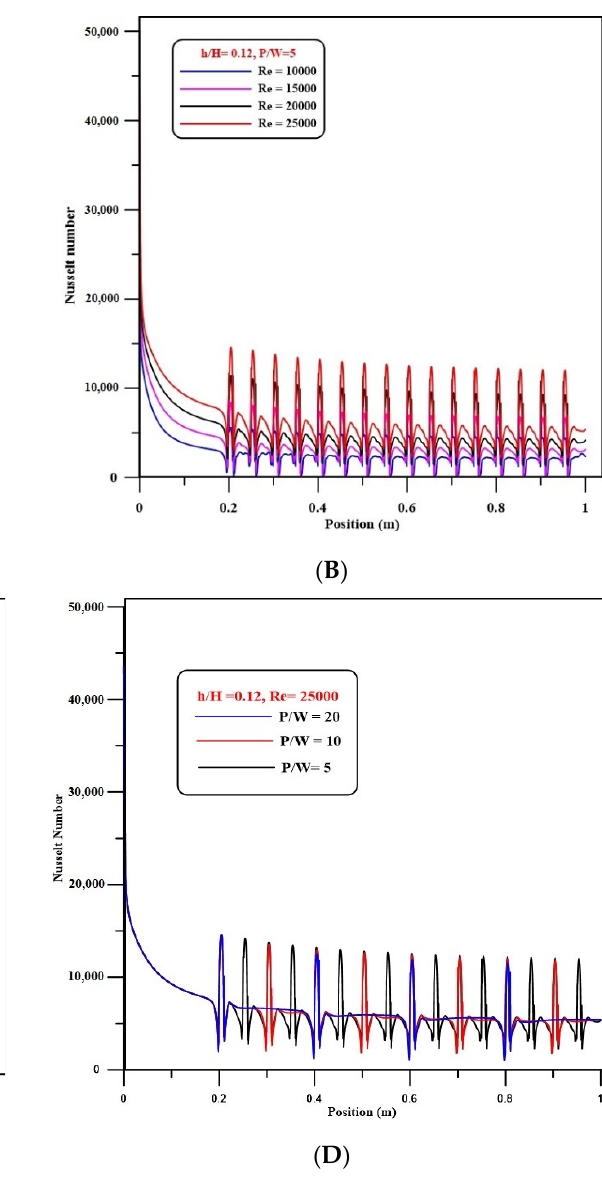
Figure 3. ( A ) Distributions of Nusselt number with different Reynolds numbers of h/H = 0.12 and P/W = 10. ( B ) Distributions of Nusselt number with different Reynolds numbers of h/H = 0.12 and P/W = 5. ( C ) Influence of pitch ratio on Nusselt number for h/H = 0.06 at Re = 25,000. ( D ) Influence of pitch ratio on Nusselt number for h/H = 0.12 at Re = 25,000.